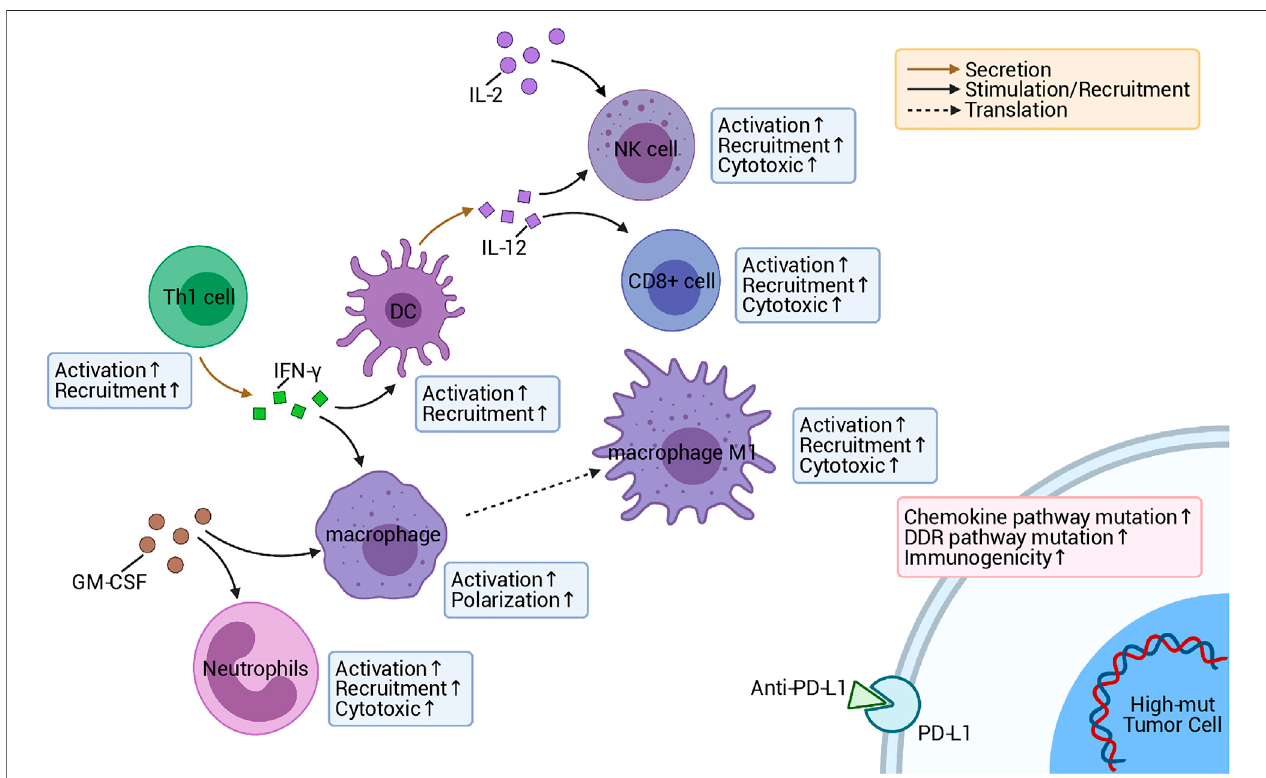
FIGURE 8 | Possible mechanism underlying the improved responses and prognosis of patients with high-mut tumors receiving ICI.